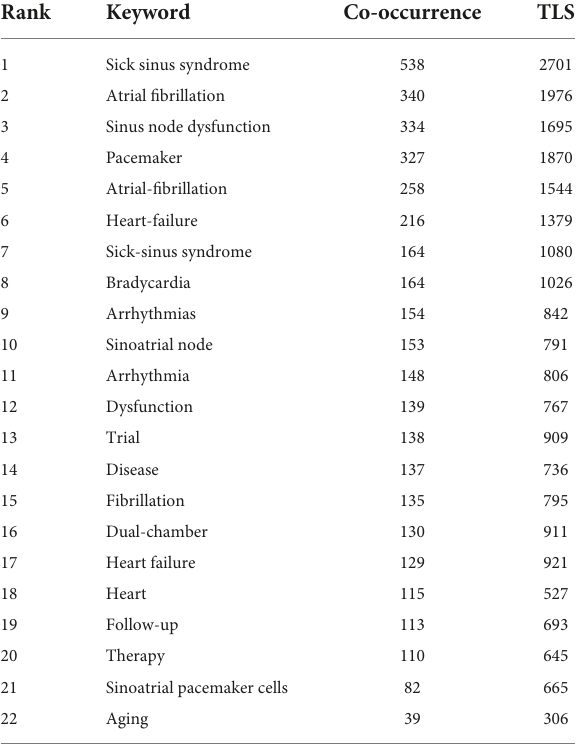
TABLE 6 The top 22 keywords in co-occurrence frequency of sick sinus